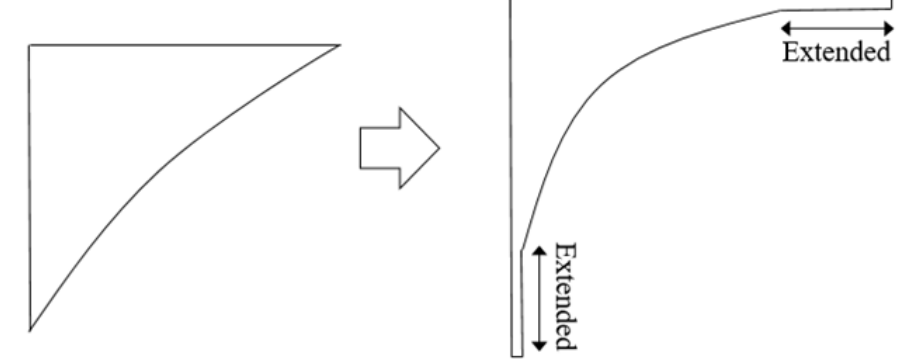
Figure 15. Corner bracket design change with extended toe.